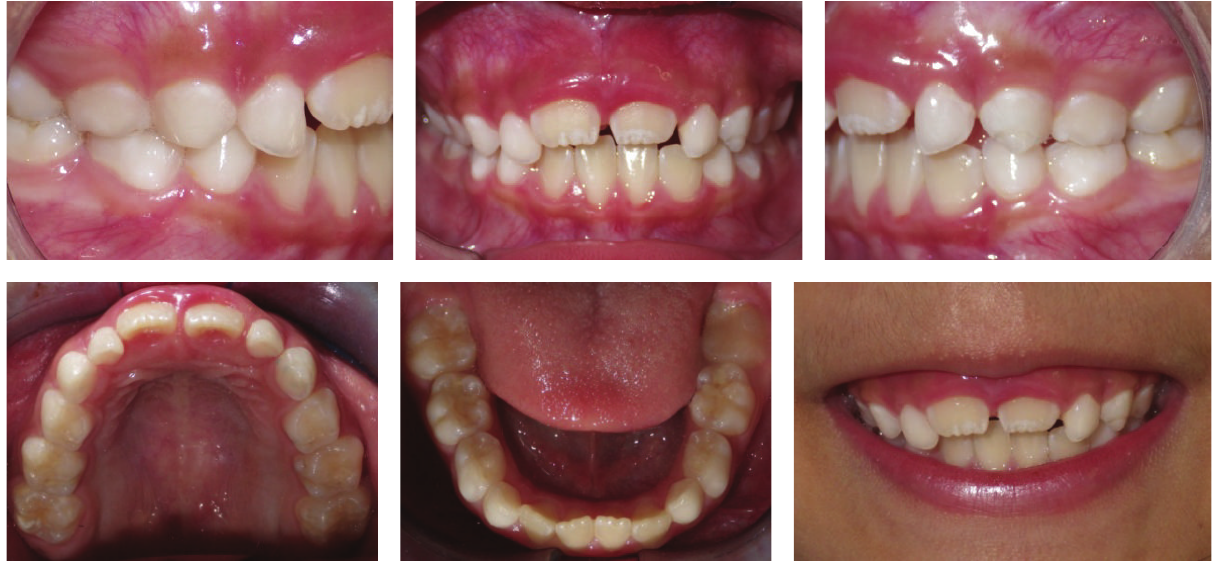
Figure 5: Nine months after removal of the palatal expander and no thumb sucking habit.